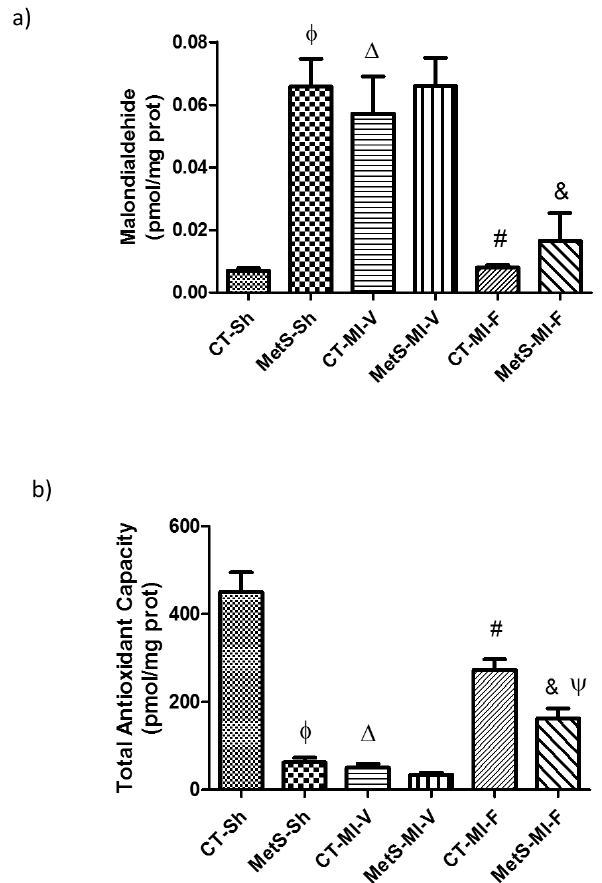
Figure 3. Effect of fenofibrate on malondialdehyde concentration ( a ) and total antioxidant capacity ( b ). Data represent mean ± SEM ( n = 5 per group). φ p < 0.05 vs. CT-Sh; Δ p < 0.05 vs. CT-Sh; # p < 0.05 vs. CT-MI-V; & p < 0.05 vs. MetS-MI-V; Ψ p < 0.05 vs. CT-MI-F. Analysis of variance-Tukey.